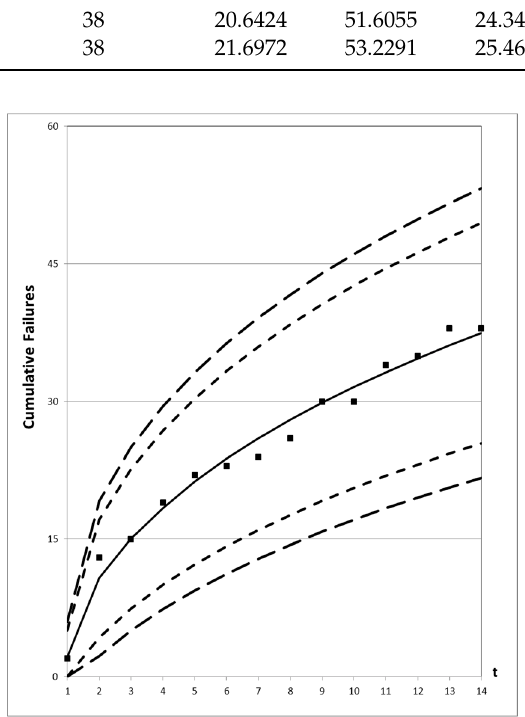
Figure 4. The 95% and 99% confidence intervals for the proposed model in dataset #1.